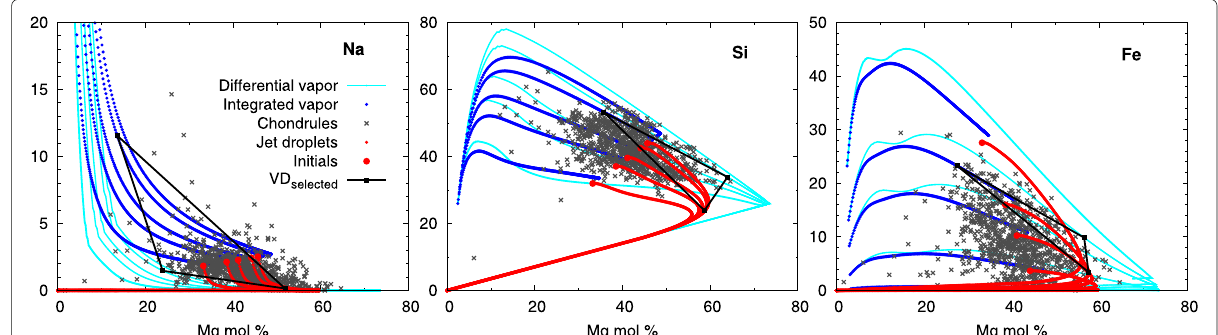
Fig. 11 Binary diagrams showing that a majority of real chondrules (crosses) is covered by the composition space defined by combinations of the three components, jet-dropet (in red), differential vapor (in light blue) and integrated vapor (in deep blue), that evolve by evaporation of the primordial silicates. Trajectories of chemical compositions (mol%) calculated for the three components are shown separately for five different initial CI sil compositions with different f s values, 0.01, 0.1, 0.3, 0.5 and 1. For the sake of visual clarity the parameter f s is not shown in the figures; in the two left-most figures, a smaller f s corresponds to higher concentrations in Mg, Na and Si for all three components; in the right-most figure, a smaller f s corresponds to lower Fe concentration. Open triangle in each figure connects the three components that coexist at a specified evaporation step (or VD%) for the same f s value, in order to show the composition space that can be expressed by combination of the three components. Such examples are shown: in the left, middle, and right figure, the triangle corresponds to f s & VD = 0.1 & 20.1%, 0.1 & 63.3%, and 0.5 & 63.3%, respectively. ‘Chondrules’ are compositions of real chondrules from all types of chondrites analyzed so far (see Appendix D for their data source). ’Initials’ are initial compositions, CI sil corresponding to the five selected f s